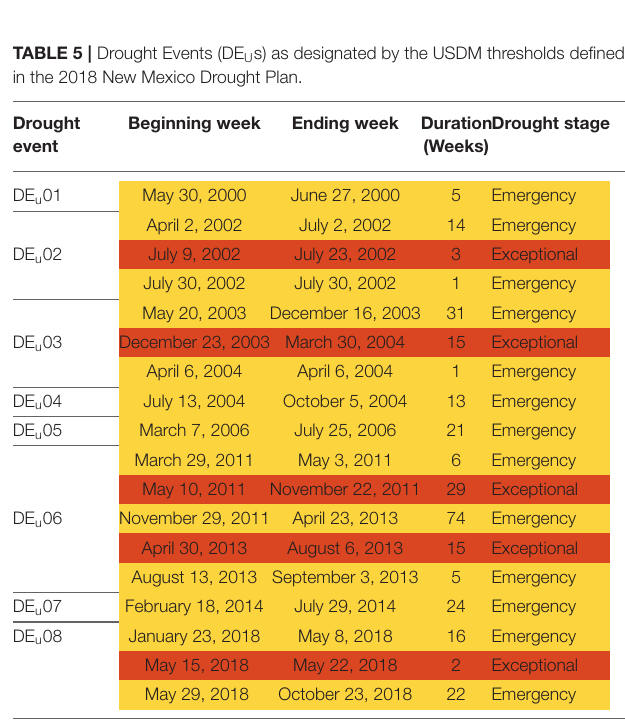
FIGURE 8 | New Mexico monthly drought impacts reported to the DIR and DSCI (2005–2020).